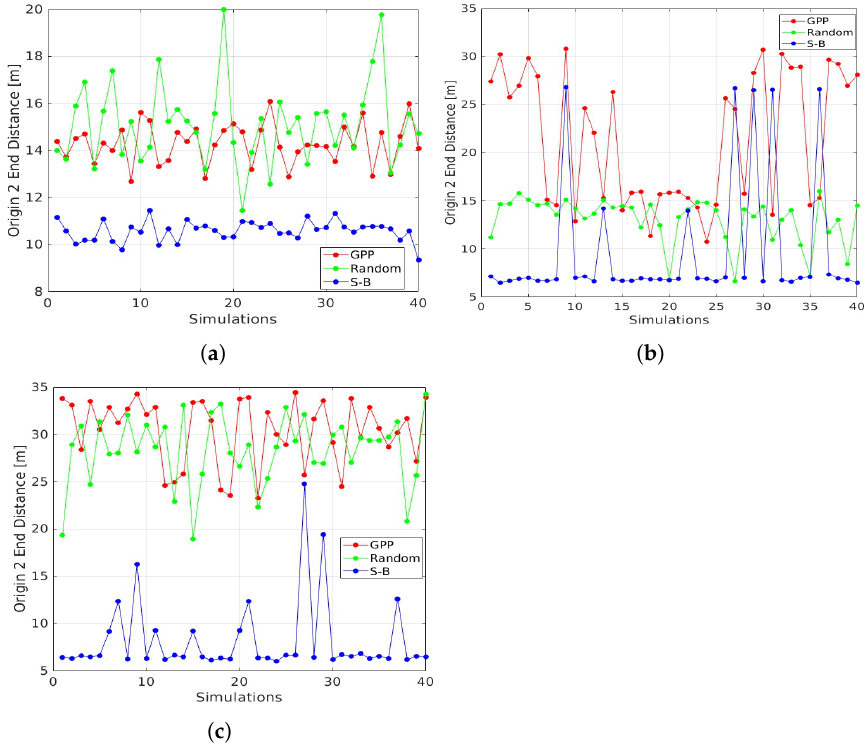
Figure 10. Origin to End distance of the path over 40 offline executions in scenario